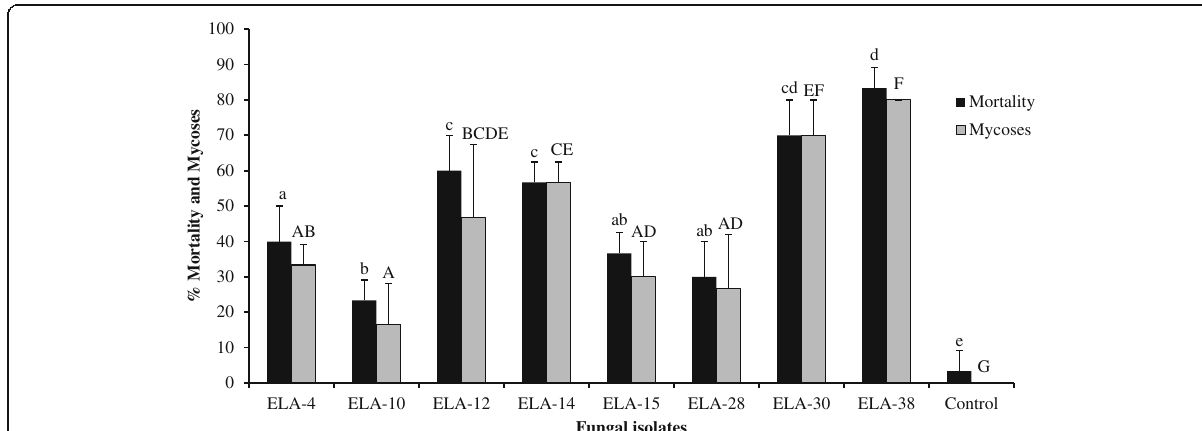
Fig. 3 Virulence of eight selected fungal isolates using the conidial concentration of 1×10 8 conidia/ml against C. pomonella larvae within 2 weeks after application. Mortality data were corrected according to Abbott ’ s formula (Abbott, 1925). Bars indicate standard deviations. Different lowercase and uppercase letters represent statistically significant differences among larval mortalities and mycosis values, respectively. ELA-4, 15, 30 Beauveria bassiana ; ELA-14 and 28 B. pseudobassiana ; ELA-10 and 12 Metarhizium robertsii ; ELA-38 M.